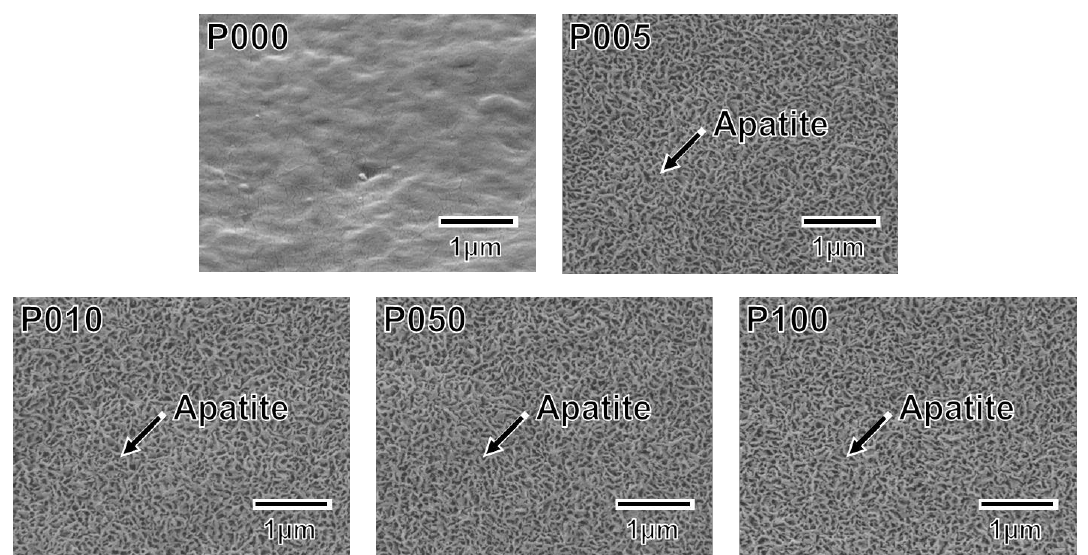
Figure 5. SEM images of the surfaces of the plate specimens P000, P005, P010, P050, and P100 following immersion in SBF for 24